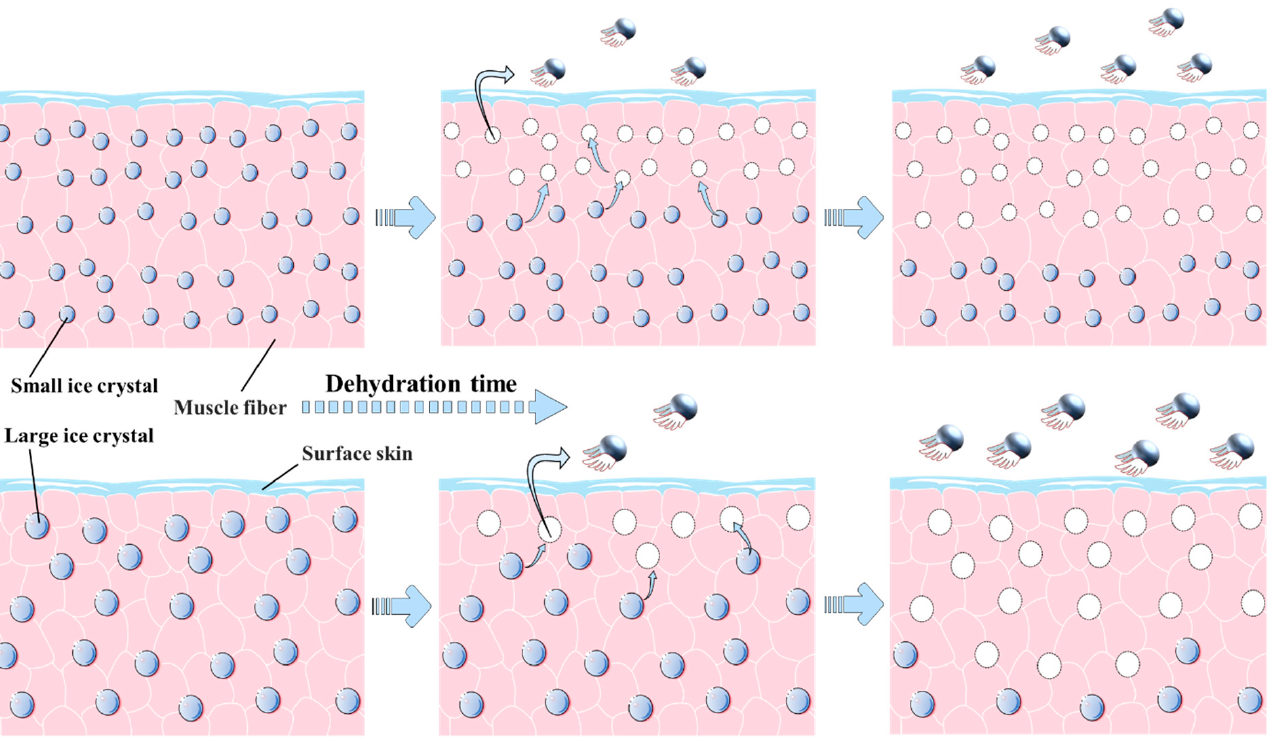
Figure 2. Schematic diagram of ice crystal sublimation during dehydration.